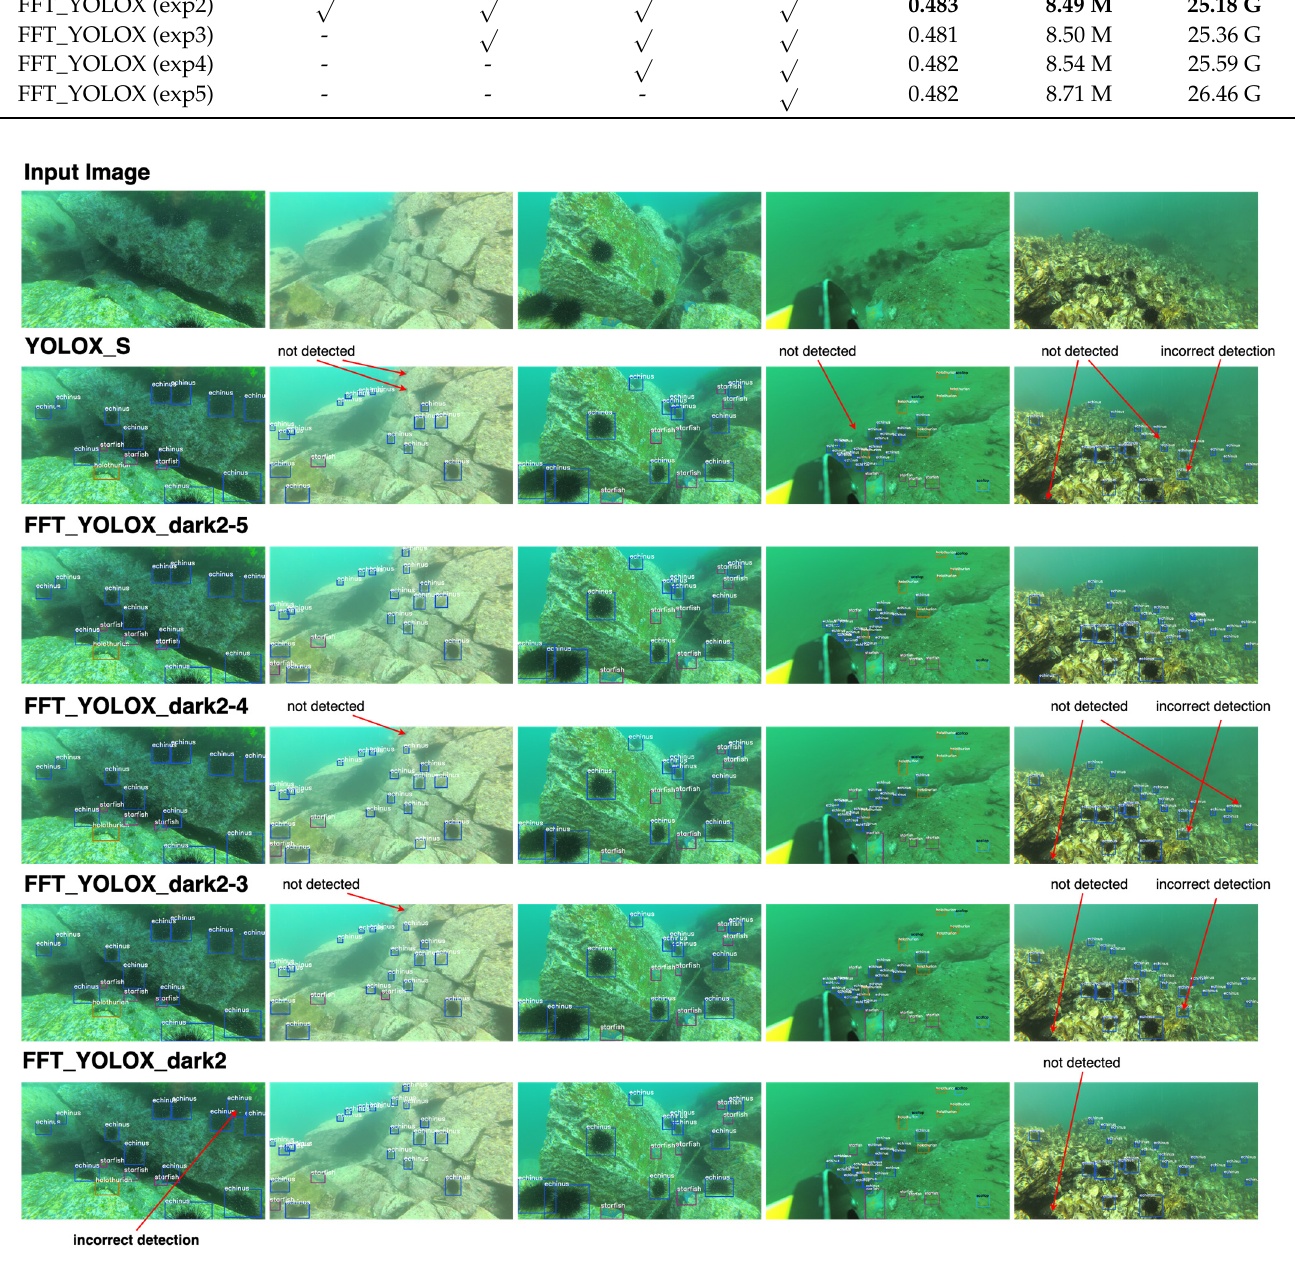
Figure 5. The qualitative comparison of the detection results of different models.